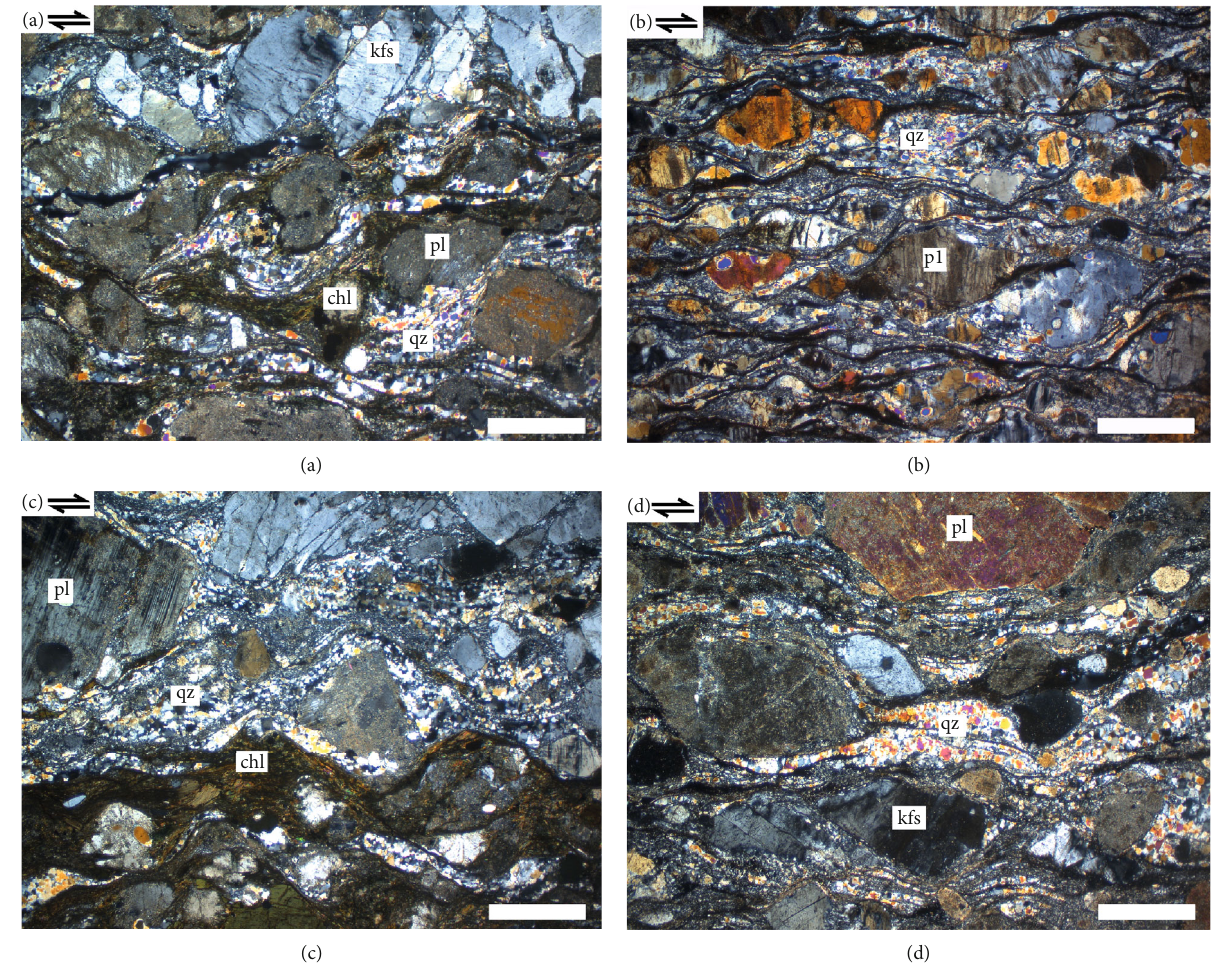
Figure 5: Representative photomicrographs of protomylonites from the KMZ. Feldspar porphyroclast contain both tensile and shear fractures, and plagioclase is heavily sericitized. Quartz is found in discontinuous ribbons with a range of grain sizes ( ∼ 10-200 μ m), de fi ning the mylonitic foliation in conjunction with the phyllosilicates. (a) Sample 29, biotite gneiss, from area D. (b) Sample 2, Tsirub Gneiss, from Area A. (c) Sample 12, biotite gneiss, from area A. (d) Sample 35, leucogranite, from area C. White bars = 1 mm